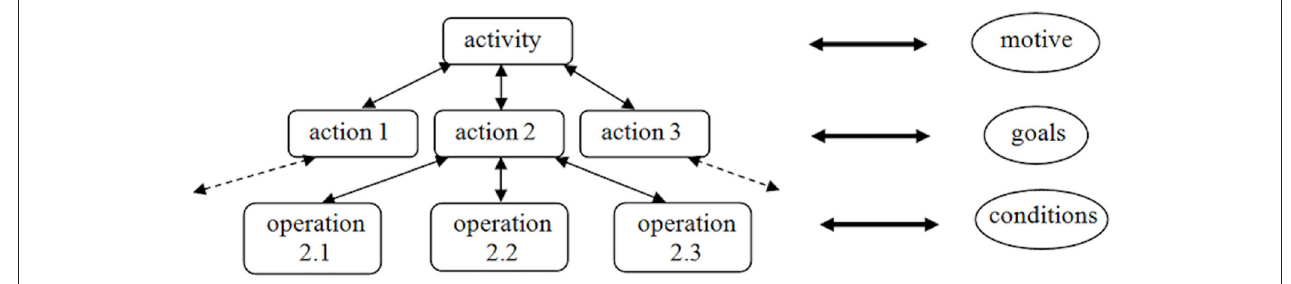
FIGURE 1 | Hierarchical structure of activities according to